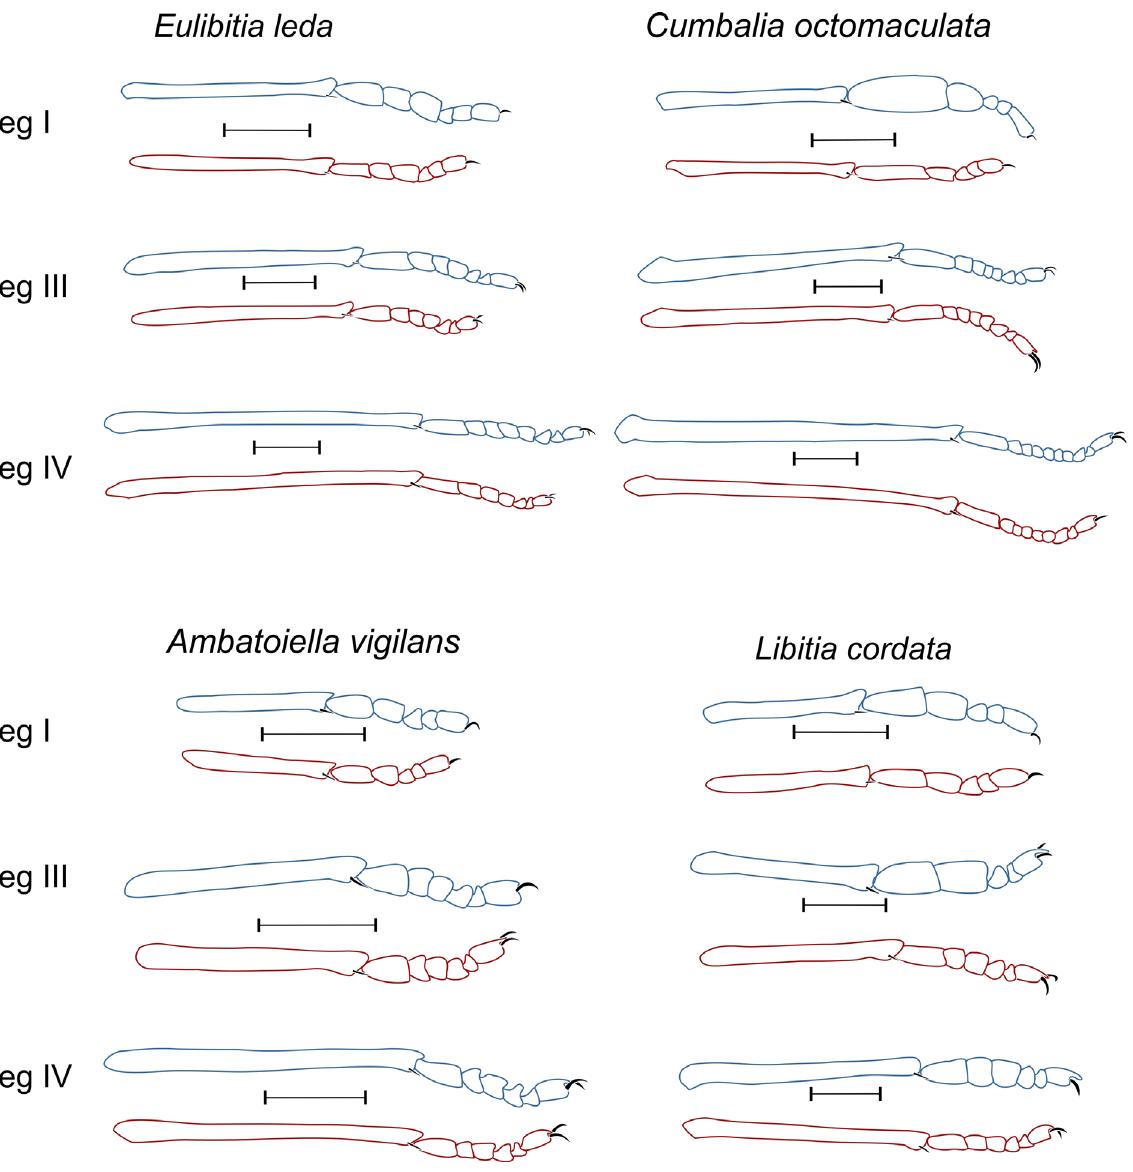
Fig. 2. Metatarsus and tarsomeres of legs I, III and IV of the cosmetine genera treated here, showing the proportions and thickening of the articles. Each pair of legs contains depiction of male above and female below. Scale bars: 1